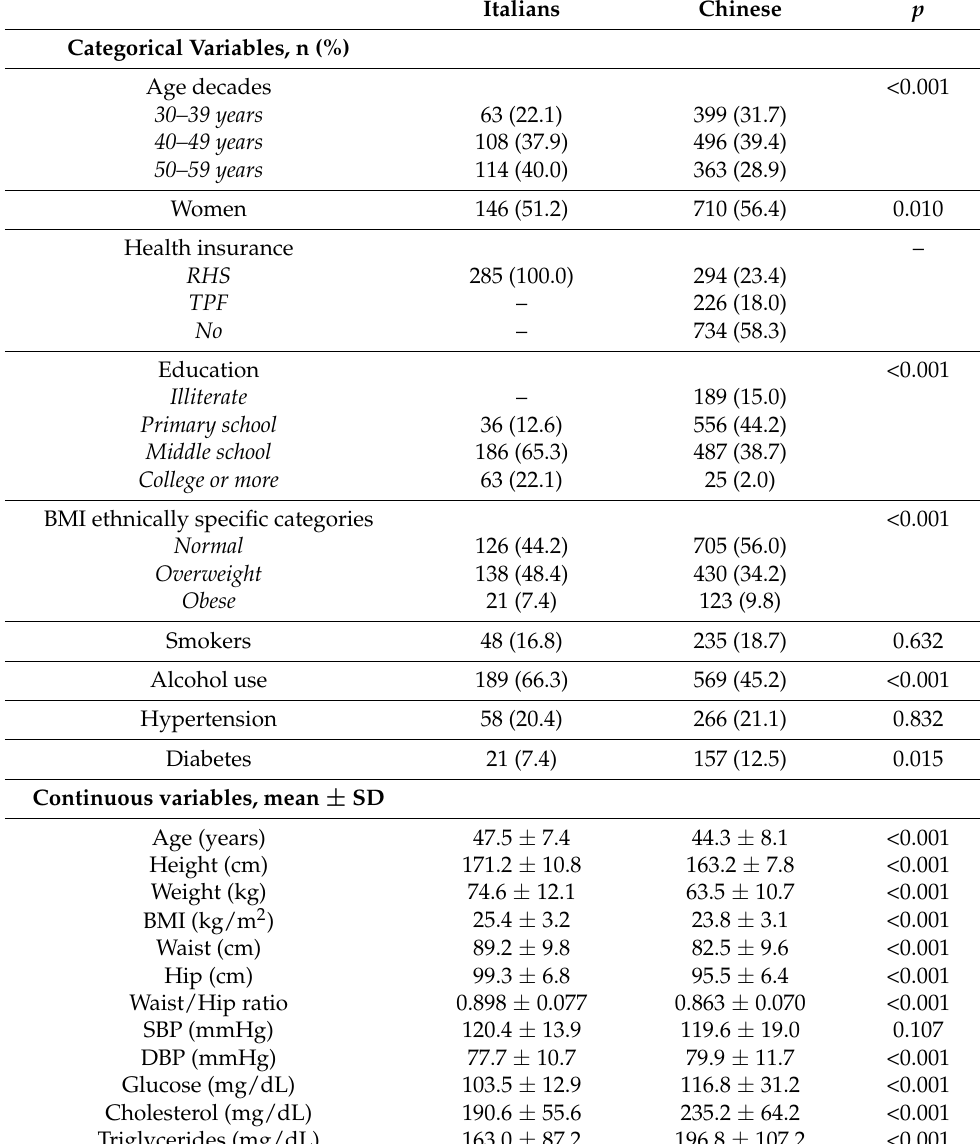
Table 1. Sociodemographic and clinical characteristics of the Italian ( n = 285) and Chinese ( n = 1258)